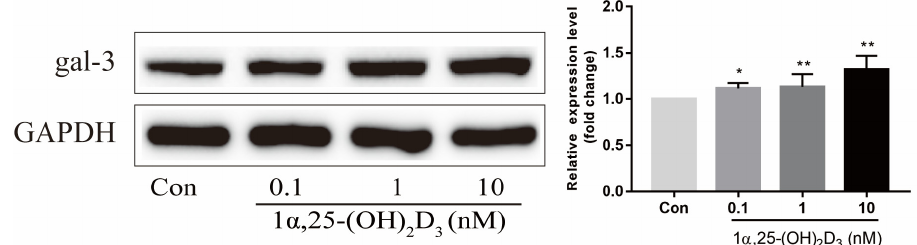
Figure 2. The expression of gal-3 protein was upregulated by 1 α ,25-(OH) 2 D 3 dose-dependently on day 3 as determined by Western blotting. Histograms show gray values of gal-3 protein. Data are shown as means ± SD. n = 5, * p < 0.05, ** p < 0.01. To confirm the effect of 1 α ,25-(OH) 2 D 3 on gal-3 protein expression at different time points, OCPs induced by 25 ng/mL M-CSF and 50 ng/mL RANKL were treated with 10 nmol/L 1 α ,25-(OH) 2 D 3 for 0, 1, 3, and 5 days. Anhydrous ethanol was used as a control. Compared with the level in the control group, 1 α ,25-(OH) 2 D 3 significantly increased gal- 3 protein expression on days 3 and 5 ( p < 0.01) (Figure 3). No significant difference was observed between the control group and the 1 α ,25-(OH) 2 D 3 group on day 1 ( p > 0.05). Compared with day 1, 10 nmol/L 1 α ,25-(OH) 2 D 3 significantly increased gal-3 protein ex- pression on days 3 and 5 ( p < 0.01). However, there was no significant change between days 3 and 5 1 α ,25-(OH) 2 D 3 groups ( p > 0.05). These data indicated that 1 α ,25-(OH) 2 D 3 promoted the protein expression of gal-3 at the same cultivation time.